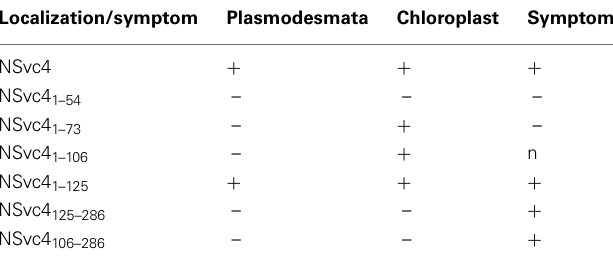
Table 2 |Targeting of NSvc4 and its mutants to plasmodesmata and chloroplast and their roles in symptom development.